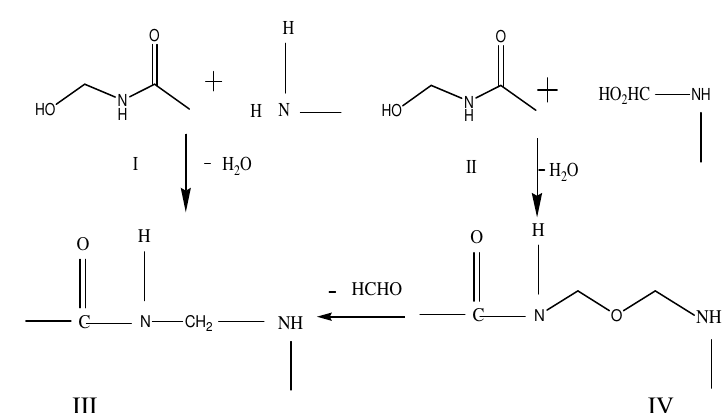
Figure 2. Scheme of condensation of methylol urea by